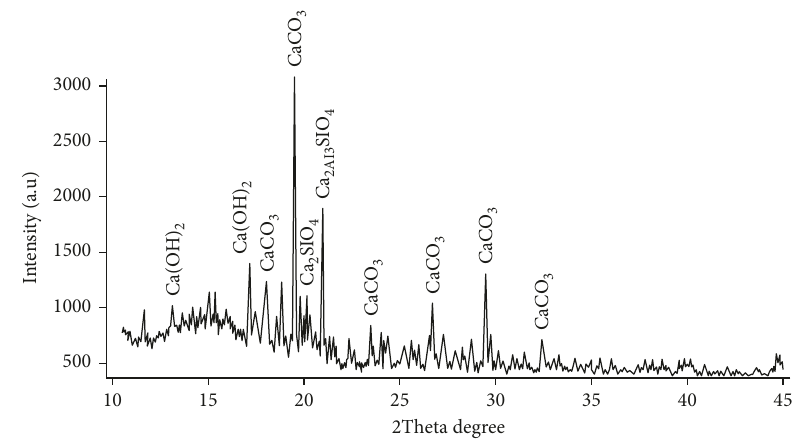
Figure 2: XRD of the aluminium alloy control